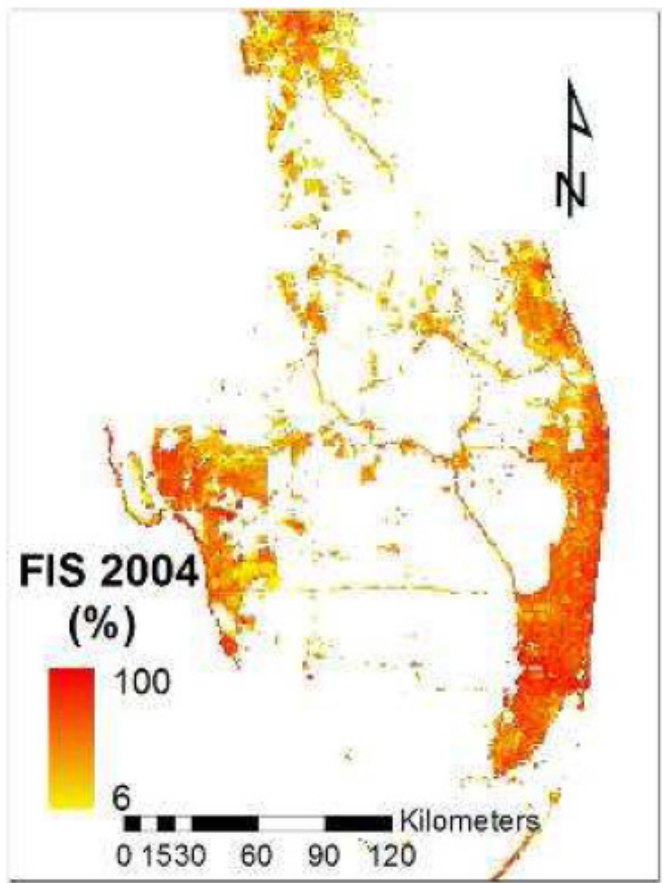
Figure 7. Percent impervious surface area of South Florida from MODIS